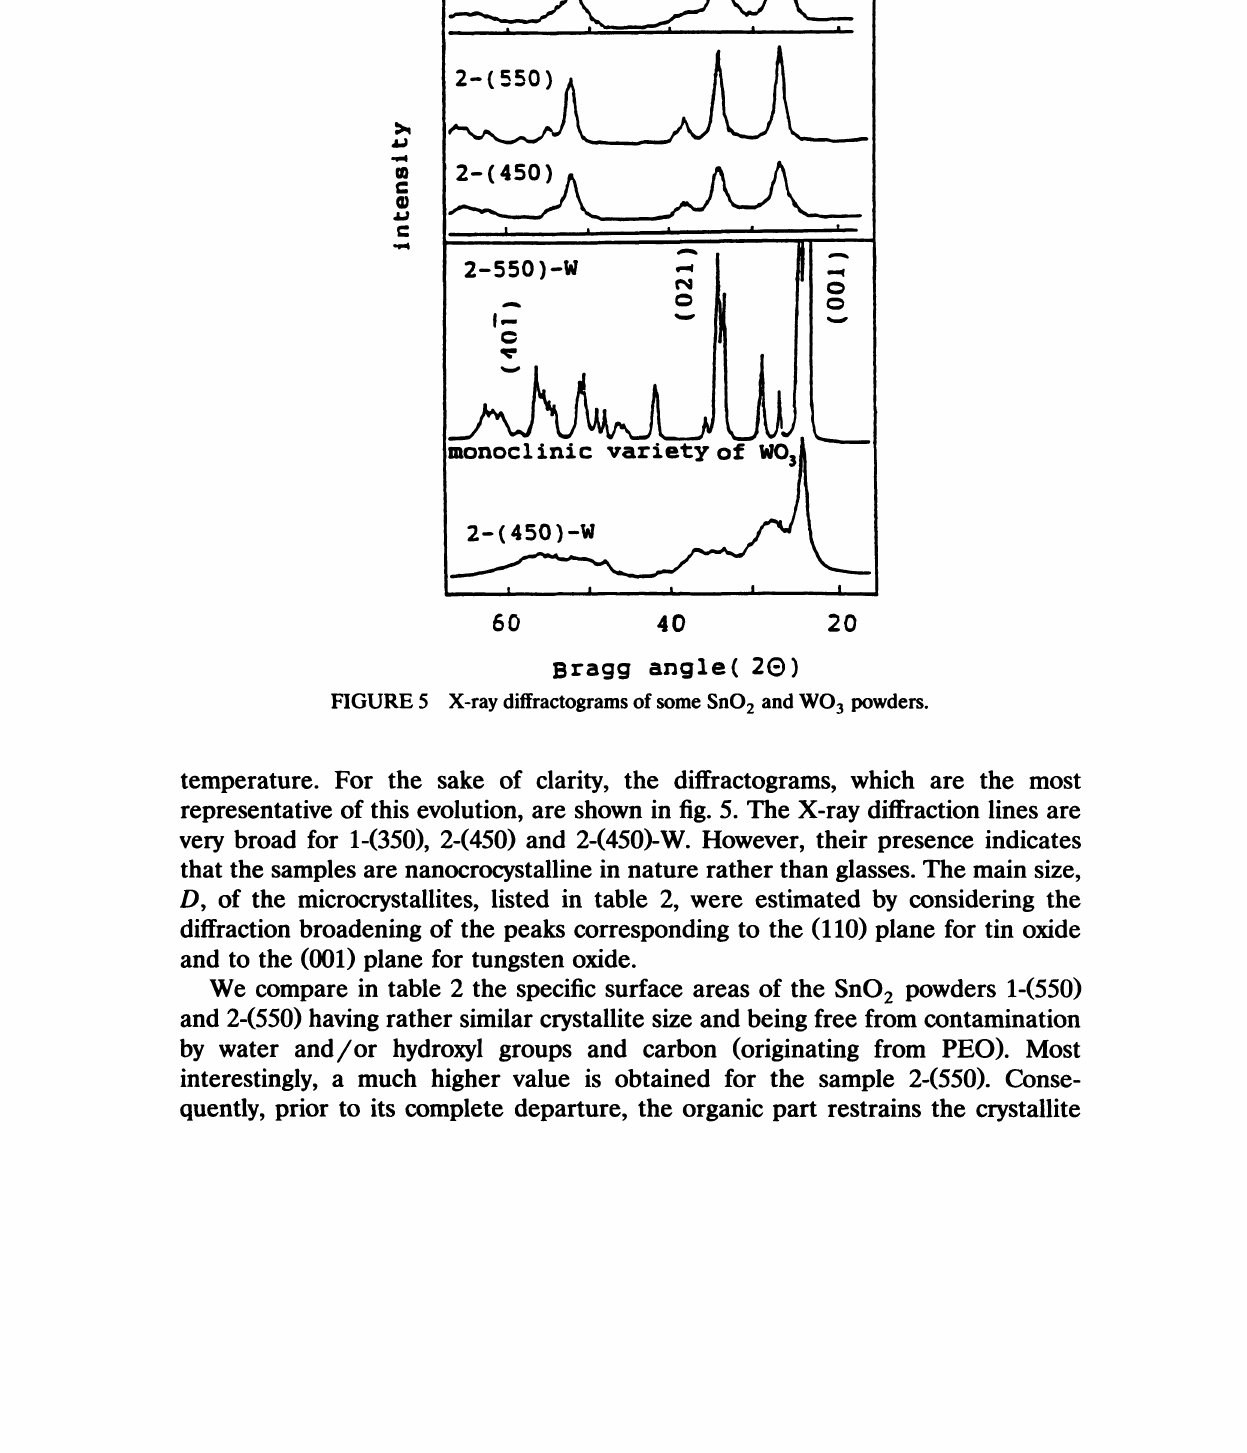
FIGURE 5 X-ray diffractograms of some SnO